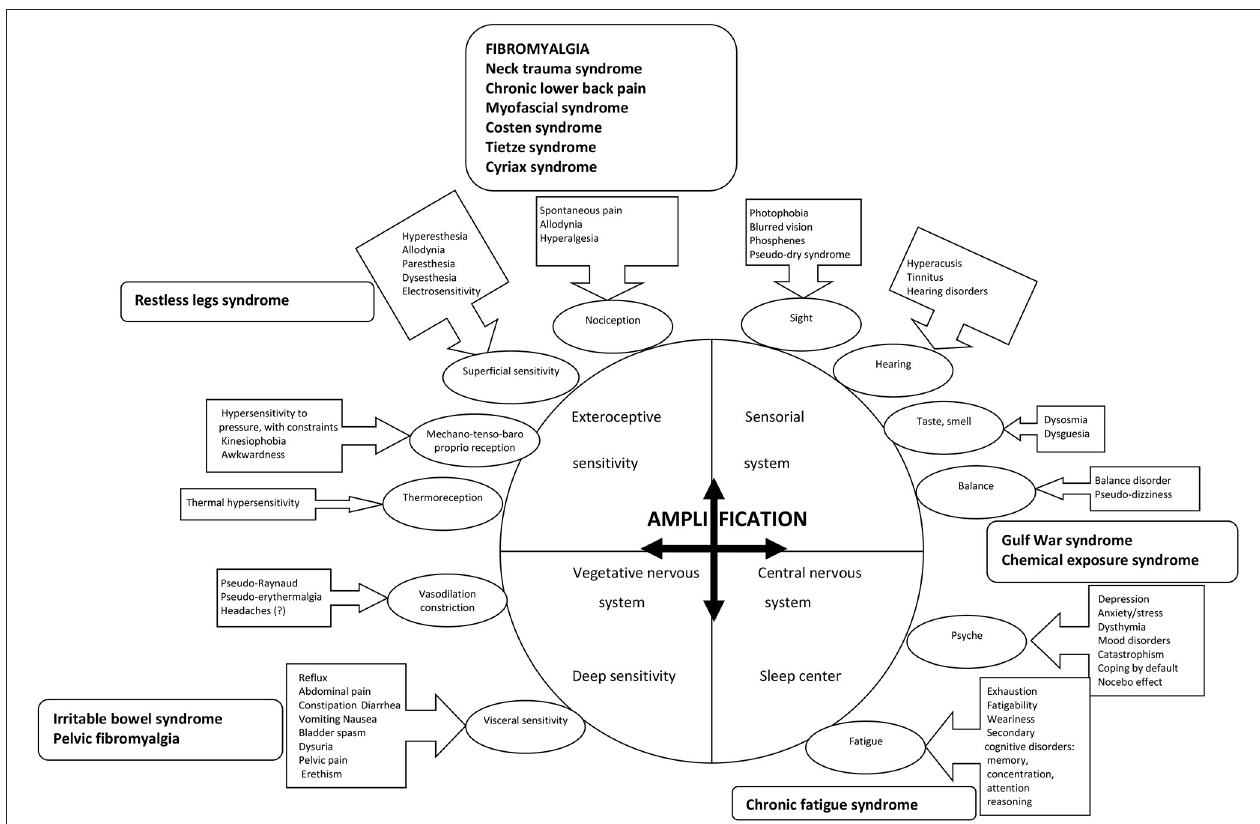
FIGURE 2 | The different paths to the origin of the stimuli responsible for the symptomatology in fibromyalgia are illustrated in the bubbles, with the associated signs in the boxes linked by arrows. The stimuli at the origin of the associated symptoms of fibromyalgia are either of exteroceptive origin, or profound, or related to the neuro-vegetative system, all with medullary relays, or in relation to sensoriality and its bulbar relays, or even central origin with regard to the psyche or fatigue. Each time, there is chronicization and amplification of the signal, which can thus only be done at the central level. The supposed mechanism is either abnormal amplification of the signal itself, or inhibition of the retrocontrol system, or a quantitative decrease in the perception threshold for the signal. A few entities (in bold in the boxes with rounded corners) are the subject of specific names in relation to the more specific predominant symptomatology, but with clear ties with fibromyalgia in the context of the hypersensitization which is common to all these